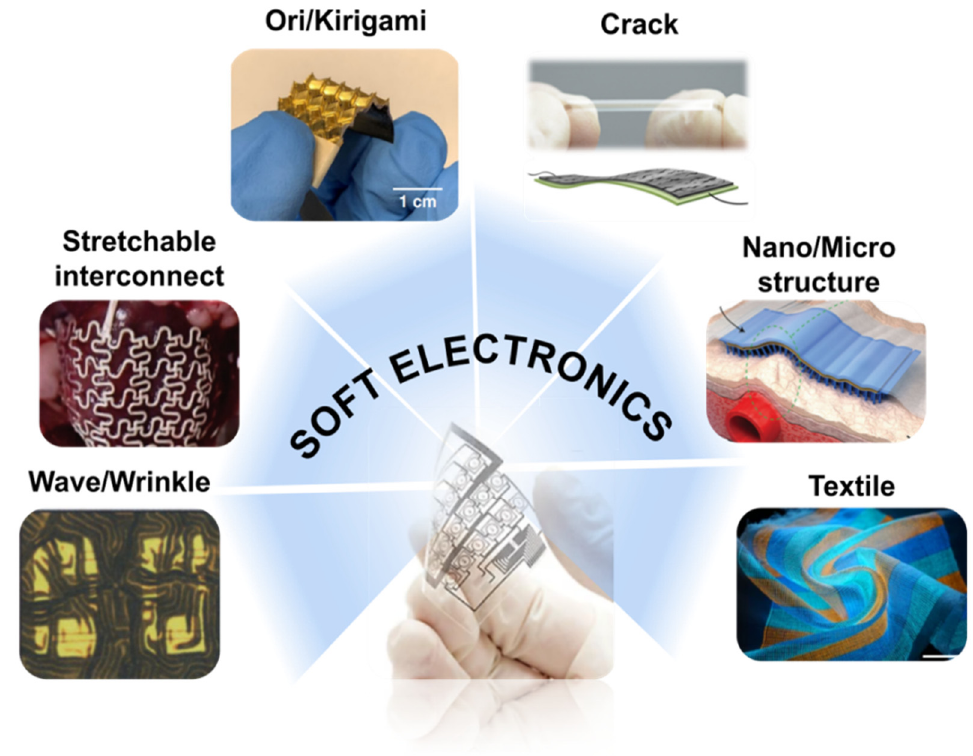
Figure 1. Review summary. Structural design, including wave/wrinkle, stretchable interconnect, origami/kirigami, crack, nano–/microstructure, and textile [13–18].